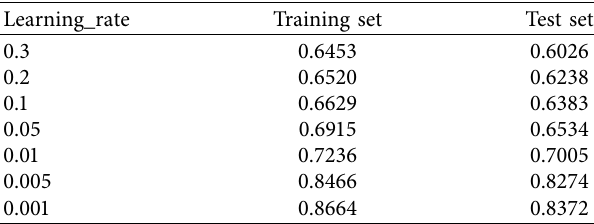
Table 8: Learning rate experiment.